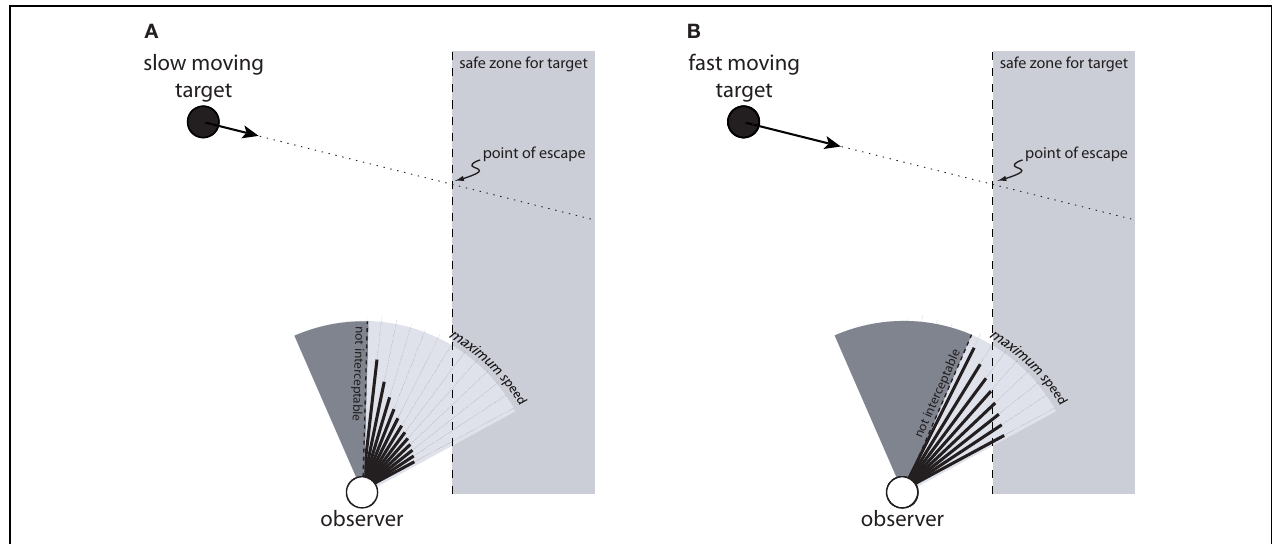
FIGURE 9 | Observer attempting to intercept a moving target before it reaches a safe zone (gray region on right side). The observer is capable of intercepting the target in (A) but not in (B)